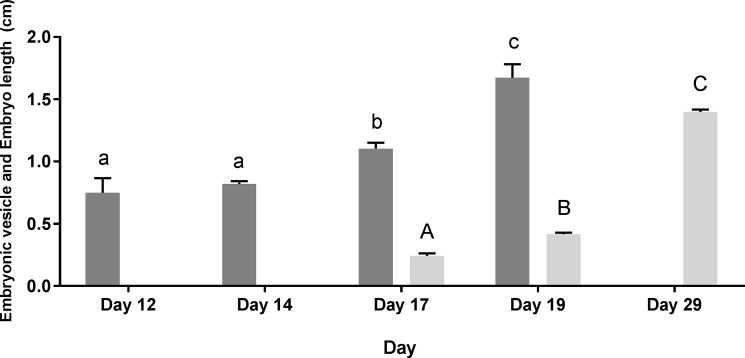
Average length of embryonic vesicles measured on day 12, 14, 17 and 19 (dark grey bars) and embryos measured on day 17, 19 and 28 (light grey bars).Values are averaged over ewe ±SEM. Columns without common superscripts differ significantly; lowercase indicates significance in relation to embryonic vesicle size, while capitalised letters indicate significance in relation to embryo size (P<0.05).